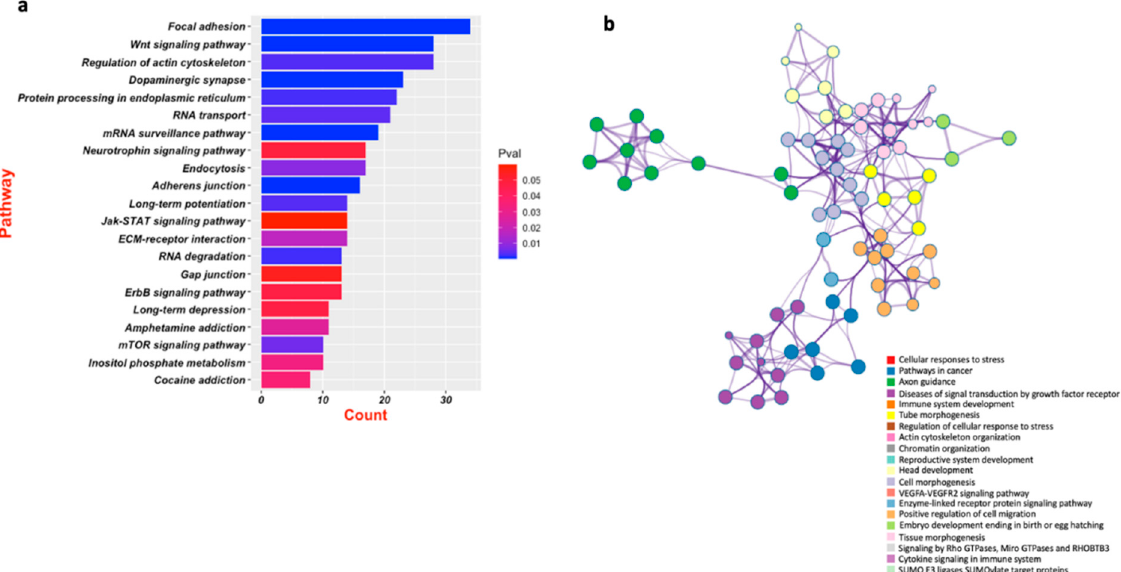
Figure 4. Brain-centric functional pathways based on an algorithmic determination of miR-218-5p target genes. Key pathways (bar plot) affected the central nervous system based on the brain-enriched predicted targets of miR-218-5p ( a ). The target pathways based on the predicted target of miR-218-5p are used to create a network map. The significantly enriched pathways from the network map, which are enriched in brain functions, are shown with color legends ( b